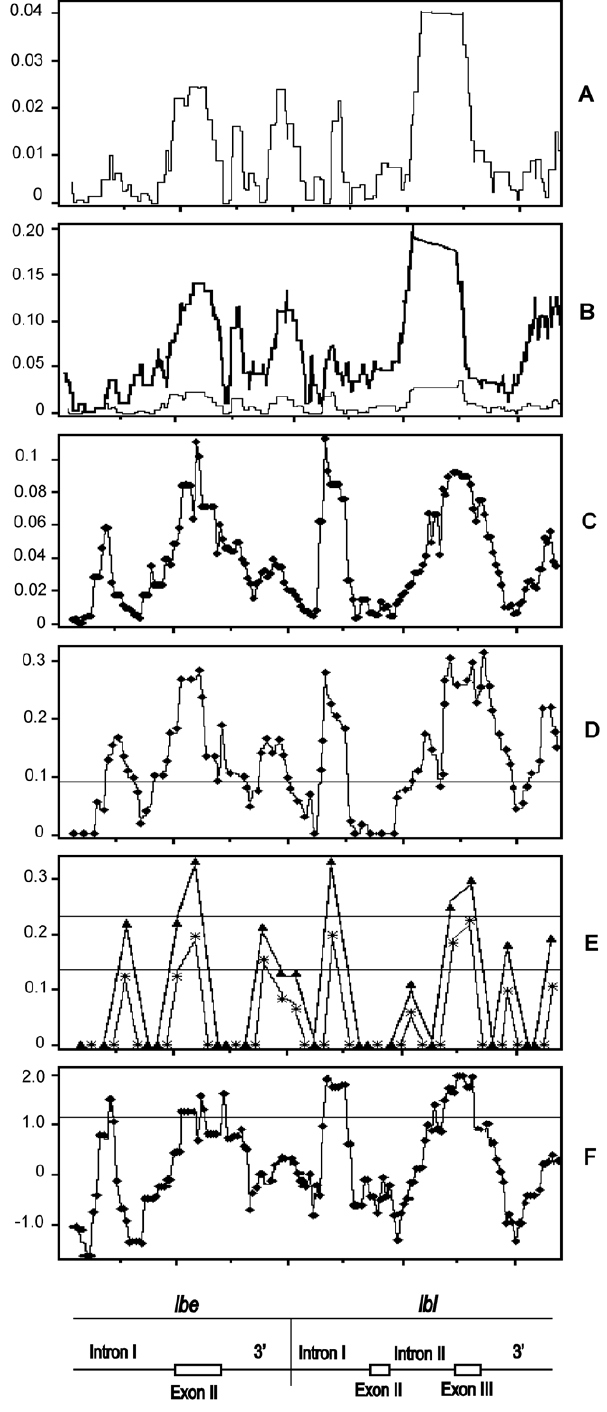
Figure 2. Sliding window plots along the lbe and lbl genes of D. melanogaster . A, silent nucleotide diversity; B, silent nucleotide diversity (thin line) and divergence (thick line); C, linkage disequilibrium measured by D ; D, E, and F, neutrality test statistics of Kelly’s Z nS [33], Wall’s B and Q [34], and Tajima’s D [35], respectively. Window sizes are 100 nucleotides with one-nucleotide increments for A and B; 250 nucleotides with 25-nucleotide increments for C; 250 nucleotides with 30-nucleotide increments for D and F; and 250 nucleotides with 150- nucleotide increments for E. A schematic representation of the region investigated is displayed at bottom. 99% confident intervals